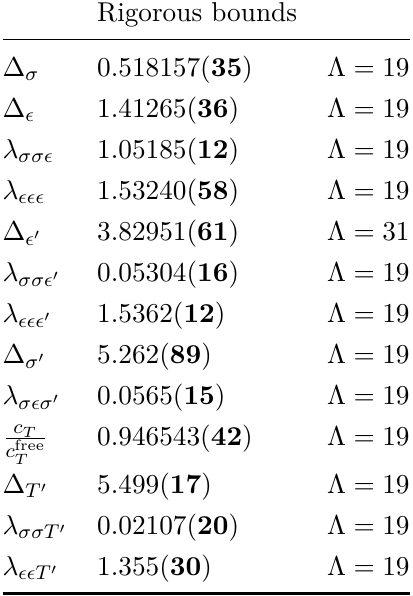
Table 1 . A summary of the strongest rigorous bounds found in this paper using various sparseness assumptions. All errors (presented in bold) are rigorous. The bounds on the first four quantities were already known [6]. The other rigorous bounds are